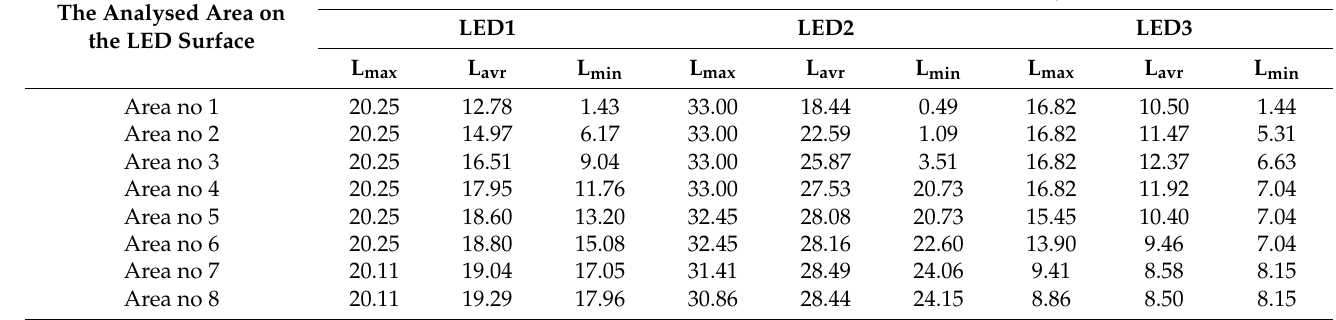
Table 3. Mean luminance, maximum luminance, and minimum luminance for different areas of examined LED surfaces (LED1, LED2 and